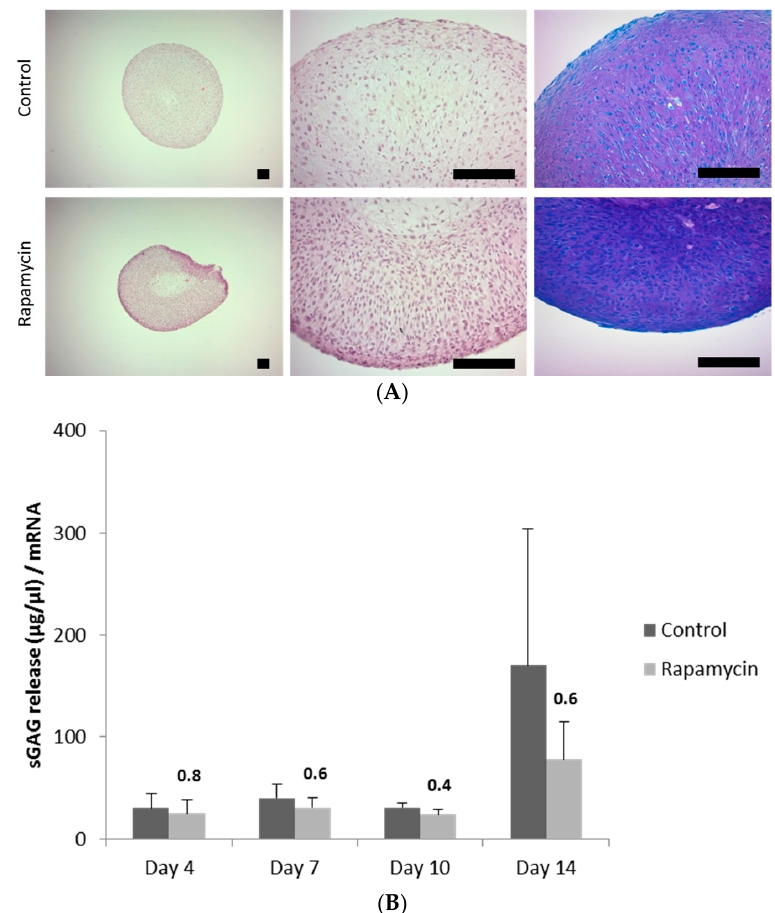
Figure 1. Blocking the mechanistic target of rapamycin complex (mTORC)1 prevents degradation of